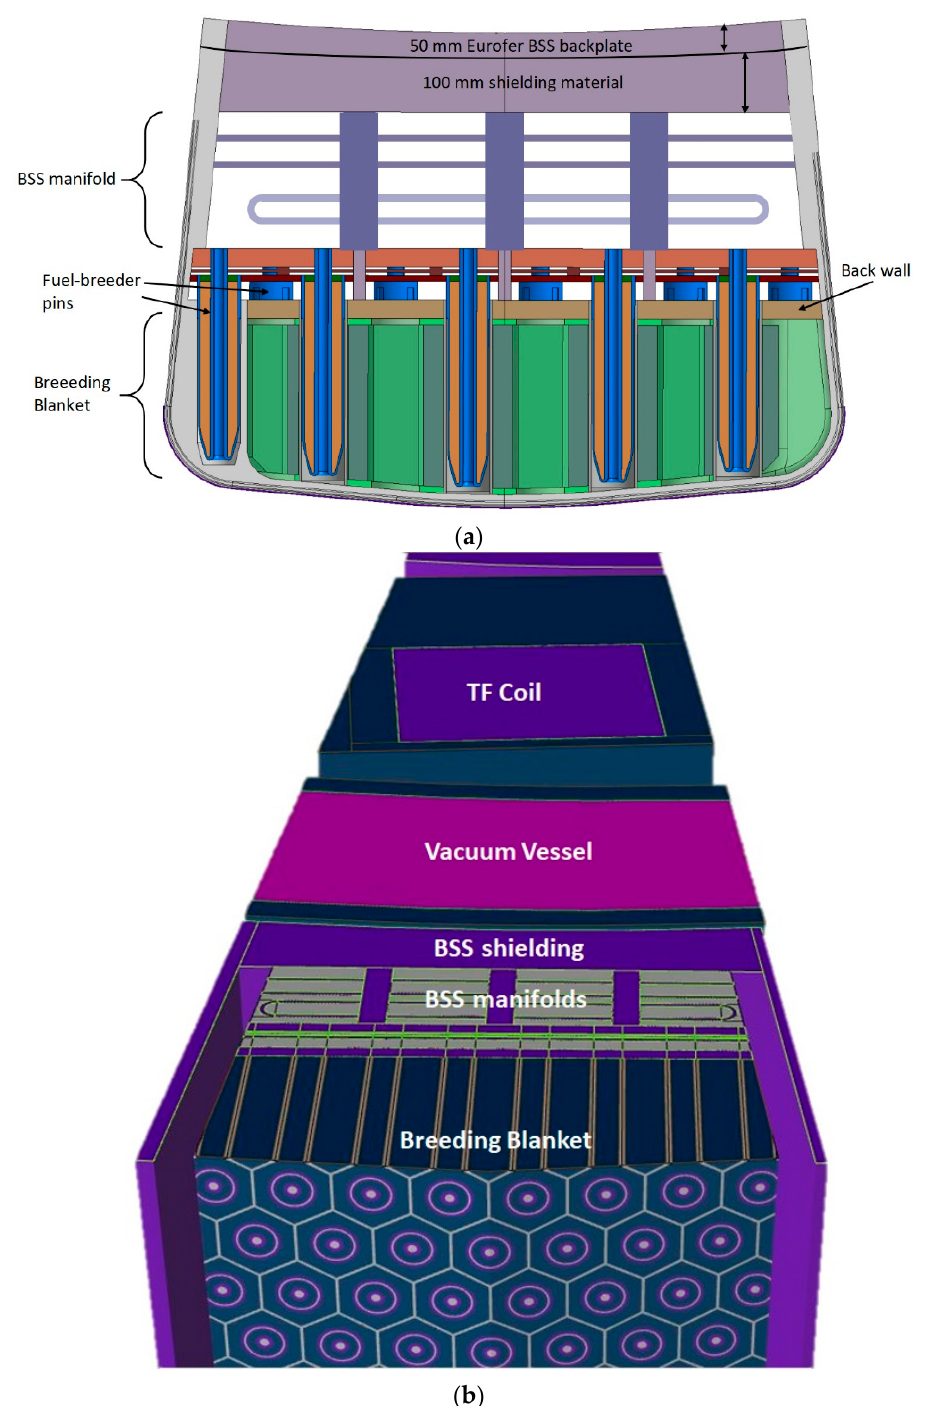
Figure 1. HCPB BB CAD model and proposed BSS segmentation for shielding assessments ( a ); neutronic detailed model of the BB, BSS, VV and TFC ( b ).